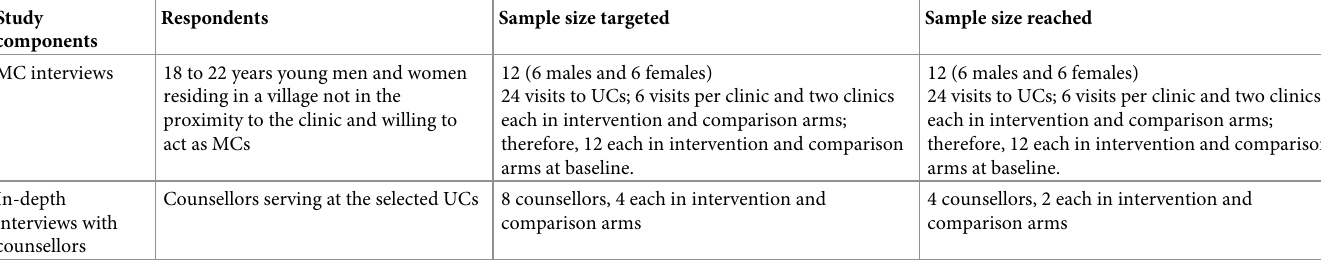
Table 1. Summary of the sociodemographic profile of the study participants and study